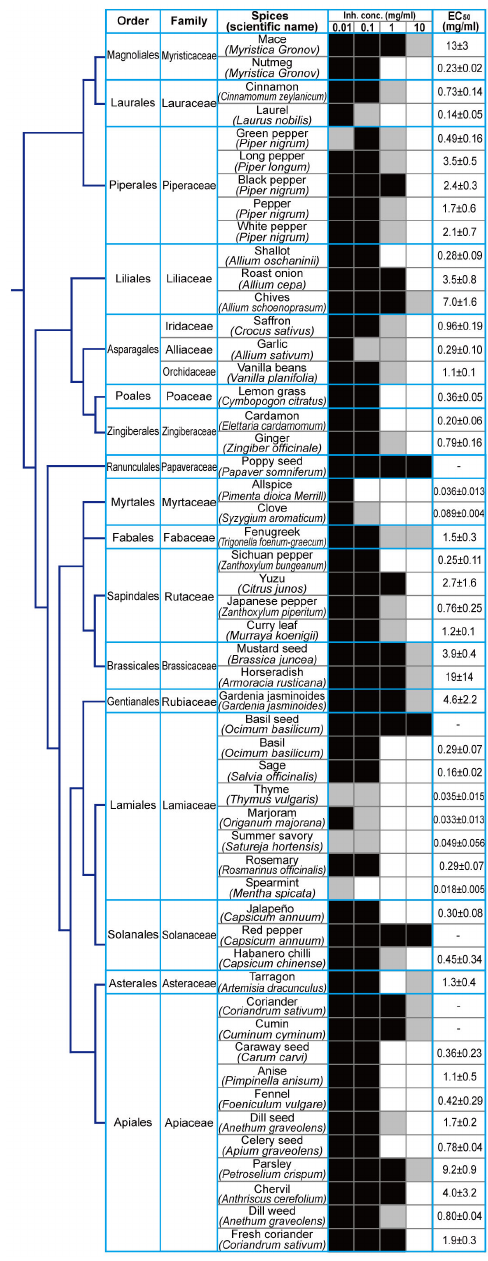
Figure 8. Estimation of EC values of EtOH extracts from 50 52 spices using the microliter-scale high-throughput screening system. Screening was applied to examine the EtOH extracts of dried spices. The ‘black’, ‘gray’, and ‘white’ cells indicate ‘not inhibited (SD ≥ 80%)’, ‘partially inhibited (80% > SD > 20%)’, and ‘completely inhibited (20% ≥ SD)’ wells, respectively. The percentage of SD was defined as SD values before and after incubation of control samples (0% and 100%, respectively). EC values were estimated from dose- 50 dependent inhibition curves (n=3 separate